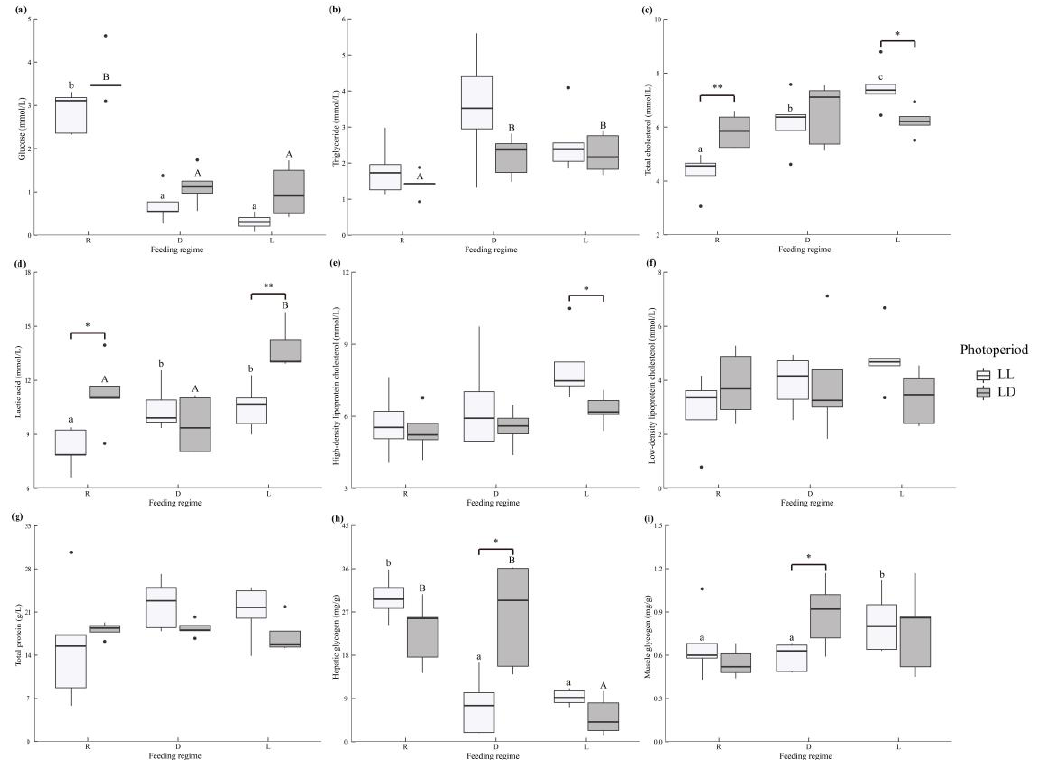
Figure 4. Serum metabolites and glycogen of juvenile Oncorhynchus mykiss under different experimental treatments (mean ± SD, n = 6). ( a ) Glucose; ( b ) triglyceride; ( c ) total cholesterol ( d ) lactic acid; ( e ) high-density lipoprotein cholesterol; ( f ) low-density lipoprotein cholesterol; ( g ) total protein; ( h ) hepatic glycogen; ( i ) muscle glycogen. Different lowercase letters and capital letters indicate a significant difference among the different feeding strategy at the LL (constant light) and LD (12L: 12D, lights-on at 6:00), respectively ( p < 0.05). Asterisks denote significant differences between photoperiods at the same feeding strategy (* p < 0.05; ** p < 0.01).